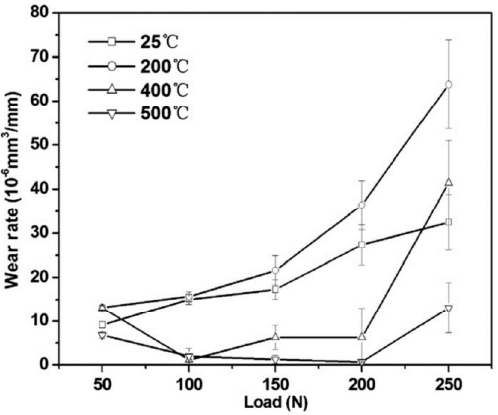
Fig. 11 Variation in wear rate with normal load on the pin at various temperatures. Reproduced with permission from Ref.